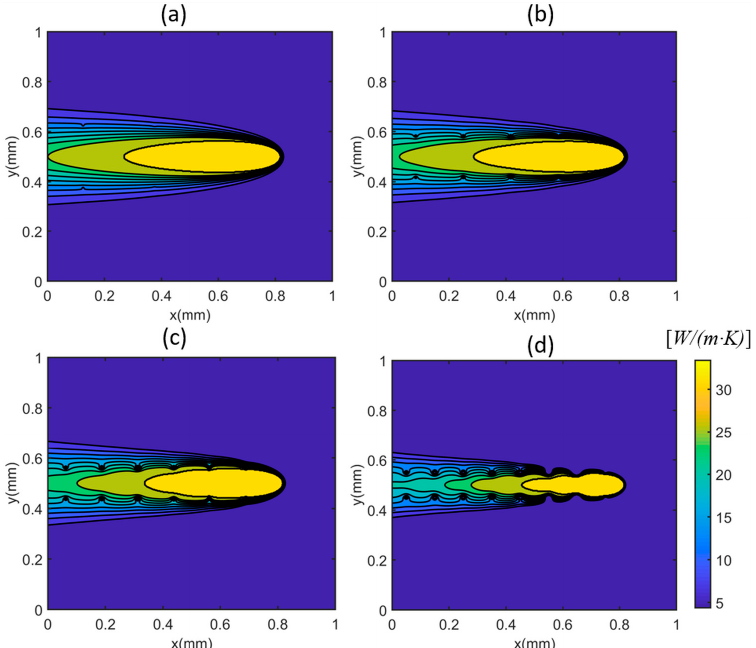
Figure 4. Calculated variations on thermal conductivity due to the single-track scans with different numbers of heat sinks: ( a ) 4 × 4 = 16 heat sinks, ( b ) 6 × 6 = 36 heat sinks, ( c ) 8 × 8 = 64 heat sinks, and ( d ) 10 × 10 = 100. The moving laser is located at x = 0.8 mm, y = 0.5 mm.